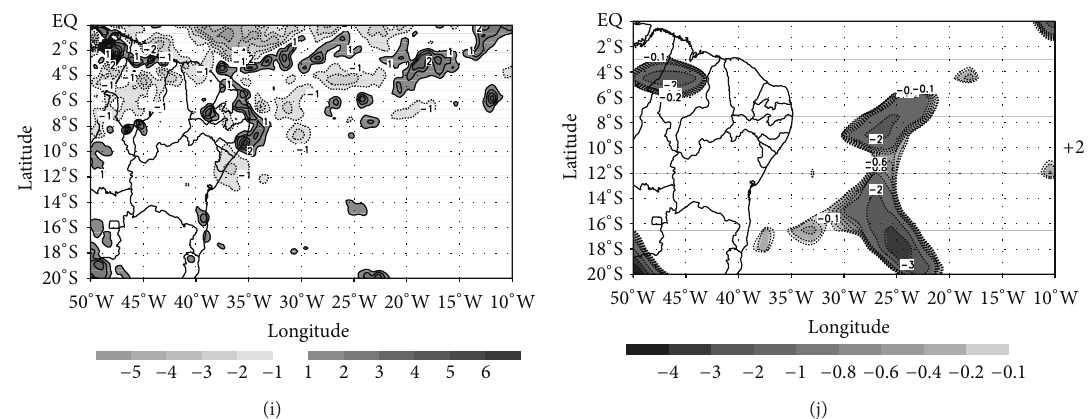
Figure 9: Precipitation (left column, mm ⋅ day −1 ) and outgoing longwave radiation (right column, W ⋅ m −2 ) composite anomalies in the period from April to July 2007.